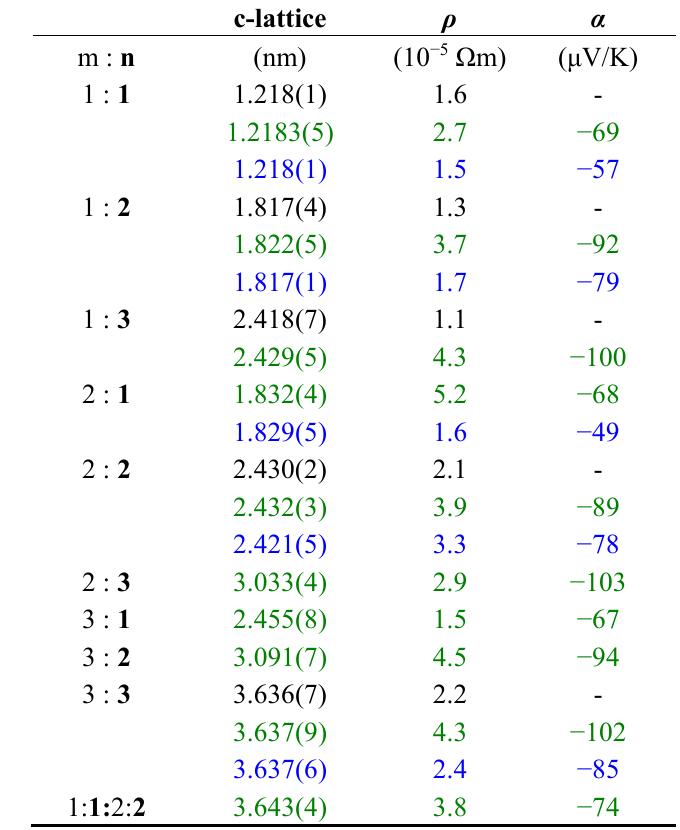
Table 1. C -lattice parameter, electrical resistivity ( ρ ) and Seebeck coefficient ( α ) for compounds in the [(PbSe) 1+ δ ] m (TiSe 2 ) n family synthesized for this study. The samples are organized by vacuum cycle in deposition equipment (black = set A, green = set B, blue = set C).